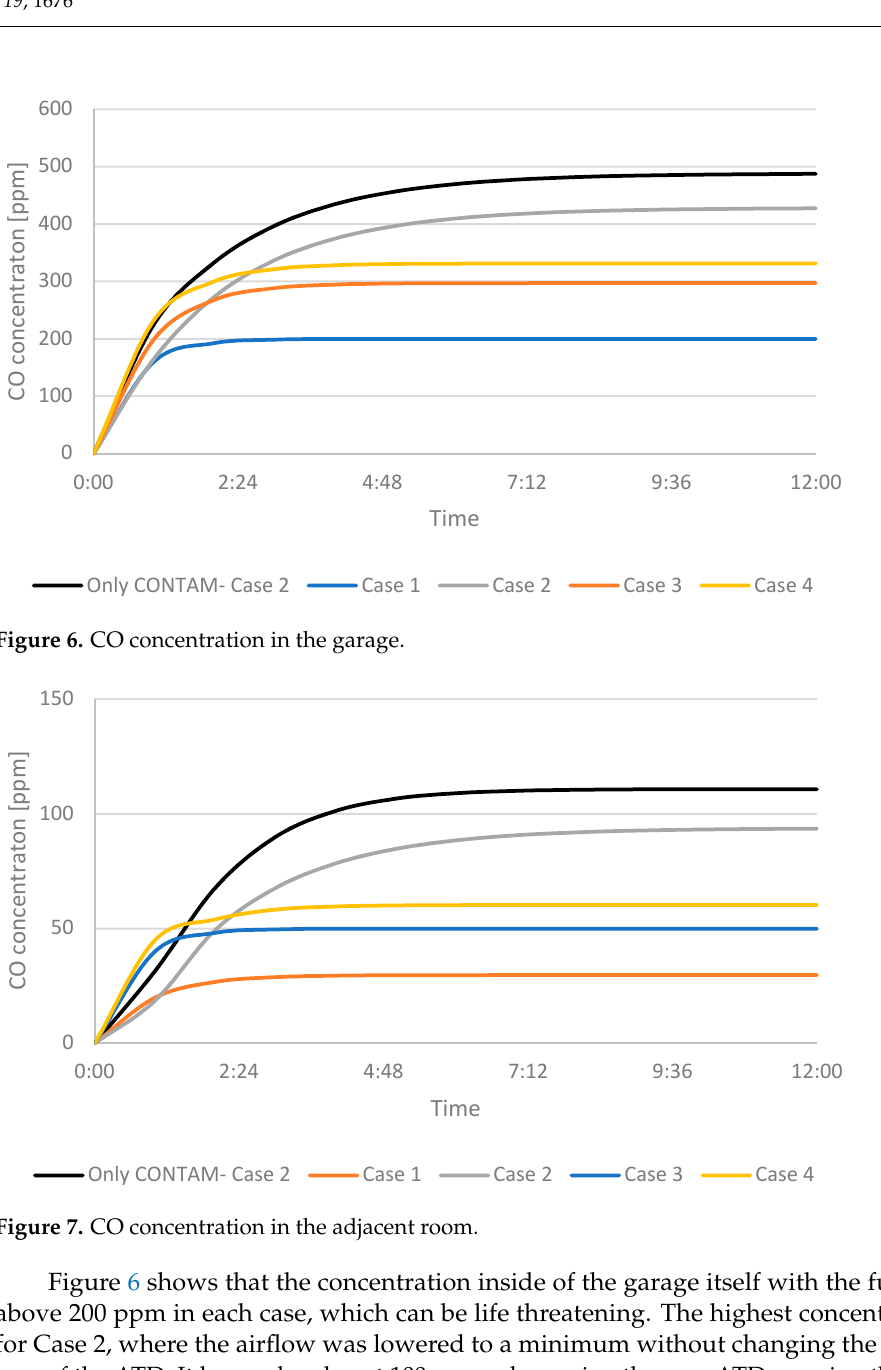
Figure 7. CO concentration in the adjacent room.